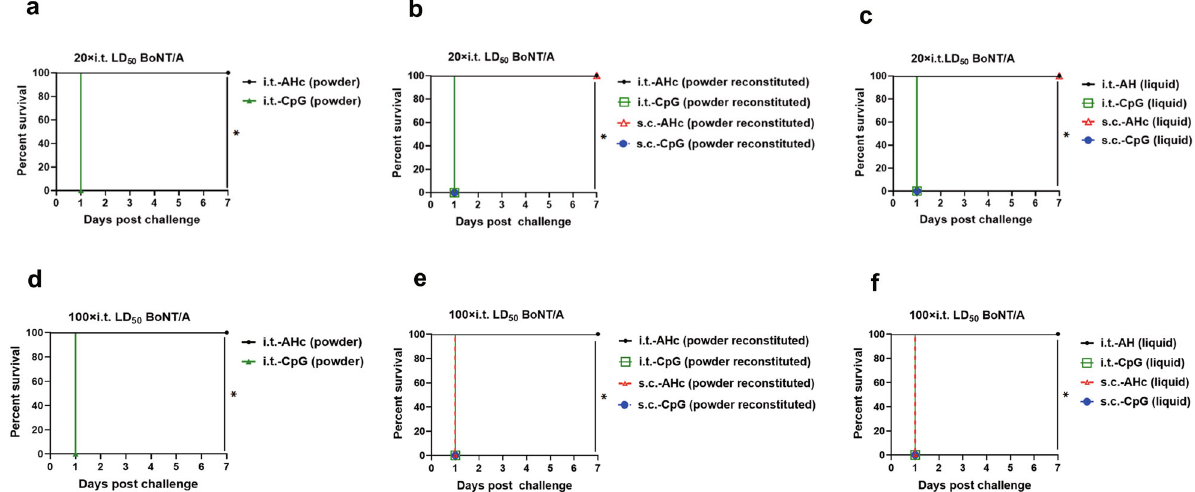
Fig. 5 BAL from AHc-immunized mice neutralized the toxicity of 20× i.t. LD 50 or 100× i.t. LD 50 BoNT/A before challenge via the i.t. route. BoNT/A was incubated with BAL from AHc-immunized mice in PBS (1:1) for 30 min at room temperature. a , d BAL from dry powder formulation-immunized mice. b , e BAL from reconstituted powder formulation-immunized mice. c , f BAL from liquid formulation-immunized mice. Then mice were challenged with a – c 20× i.t. LD 50 ( n = 5) or d – f 100× i.t. LD 50 ( n = 10) of BoNT/A that had been preincubated with BAL from different groups. The animal survival rate was analyzed by Kaplan – Meier survival estimates. * P <